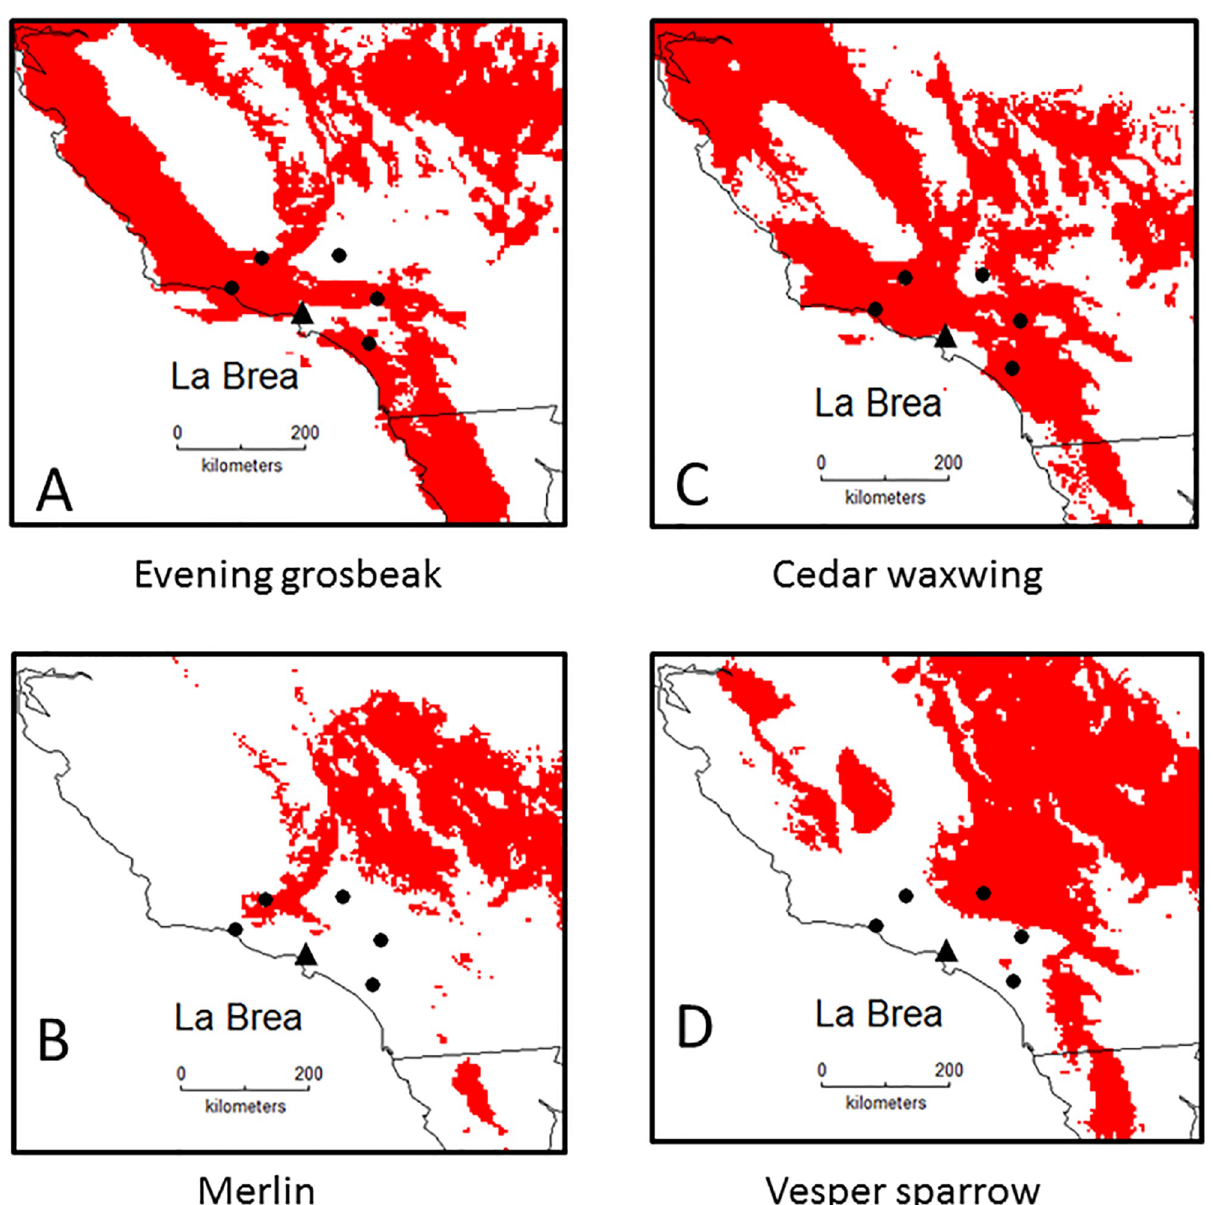
Fig 2. Predicted Last Glacial Maximum breeding distributions of four species. The triangle indicates the location of La Brea, and the five filled circles are 100 km from La Brea.